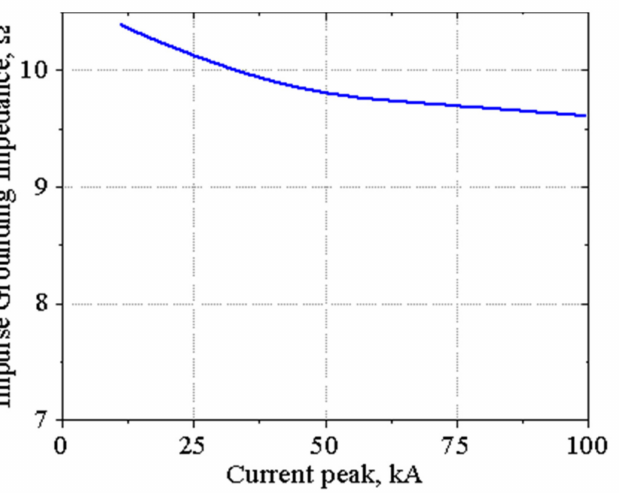
Figure 12. Influence of the current peak on the impulse grounding impedance of a 1 × 1 mesh of 10 m, soil resistivity of 500 Ω m, critical electric field of 10 kV/cm and 1/200 µ s waveform. The behavior of the impulse grounding impedance as a function of the critical electric field of the soil is shown in Figure 13. It may be noted that the impulse grounding impedance increases slightly when the critical electric field of the soil for the 1 × 1 mesh